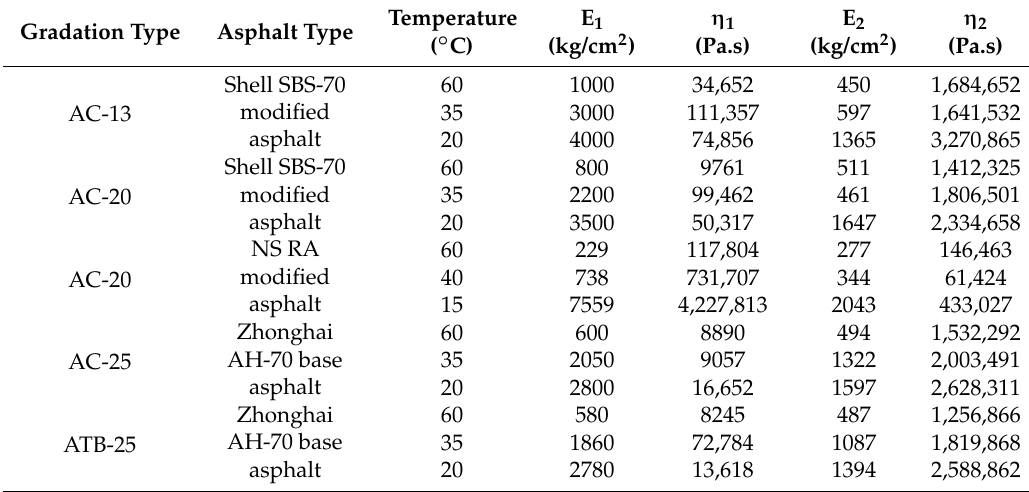
Table 6. Calculation parameters of asphalt mixtures.